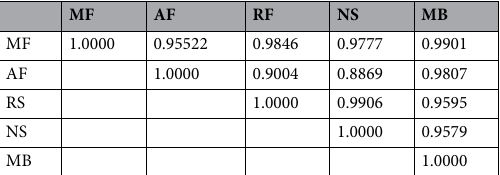
Table 1. Correlation coefficients among behavioral profile (SHIRPA protocol) of animals infected with C. gattii and treated with amphotericin B (AMB), fluconazole (FLC15 and FLC150) and the combination FLC15 + AMB and FLC150 + AMB. MF: muscle tone and strength, AF: autonomic function, RF: reflex and sensory function, NS: neuropsychiatric state and MB: motor